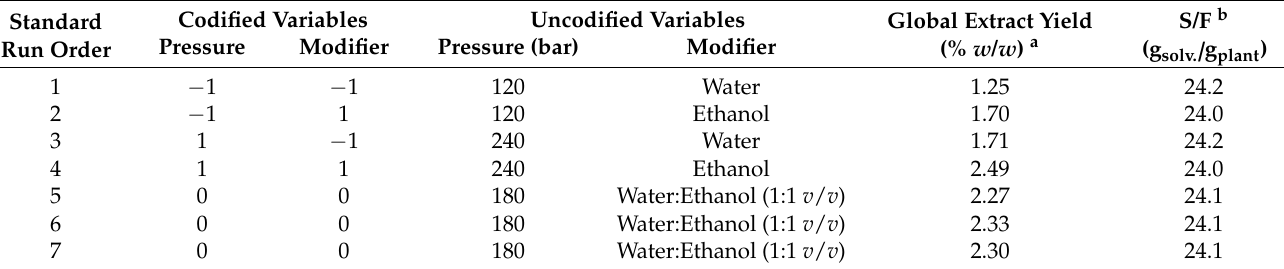
Table 1. Factorial 2² design matrix and observed responses.